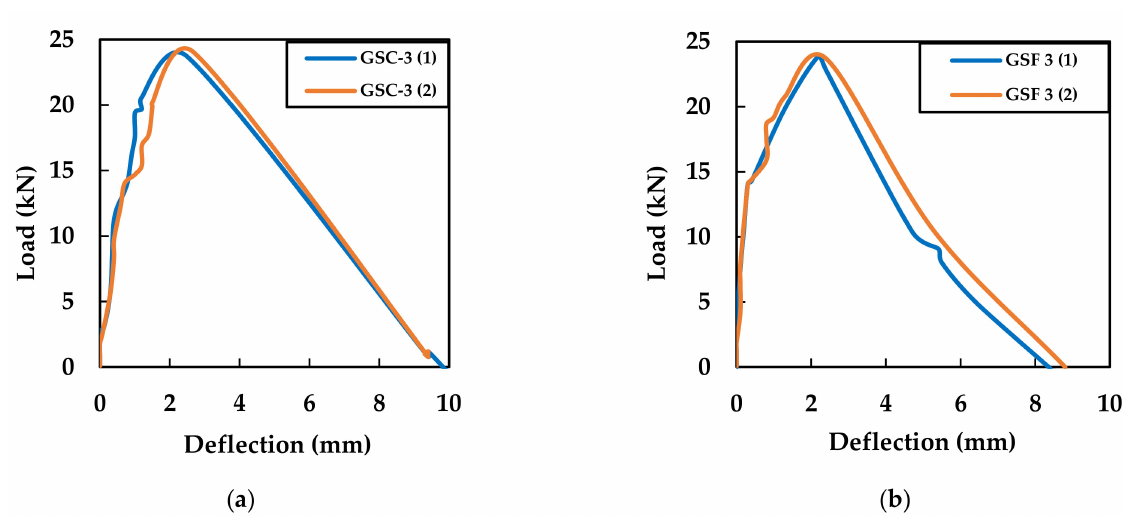
Figure 9. Load–deflection behaviour of ( a ) GSC-3 and ( b )